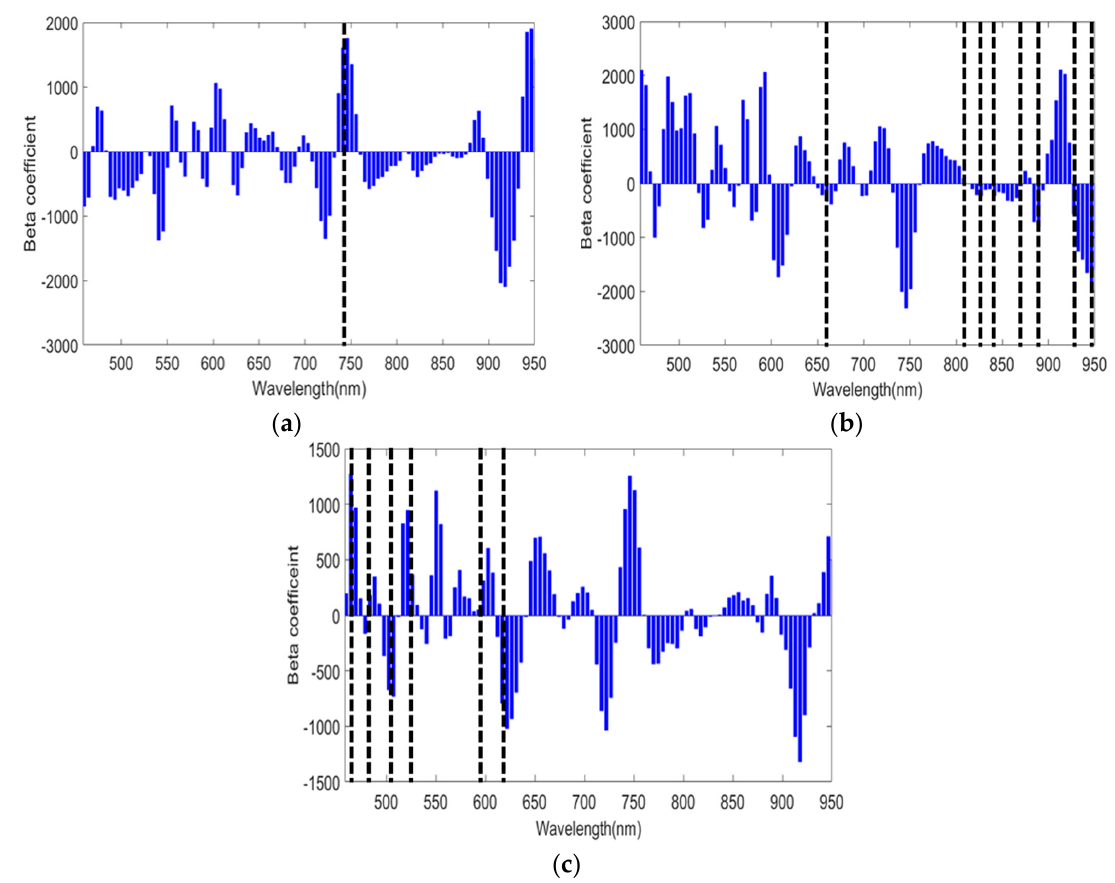
Figure 4. Selection of light-emitting diode (LED) wavebands using hyperspectral imaging (HSI) data based on beta coefficient plot. The selected wavebands were further used for multispectral system: ( a ) Selected regions for moisture content; ( b ) Selected regions for fat content; ( c ) Selected regions for protein contents. The dashed lines correspond to the central wavelengths.